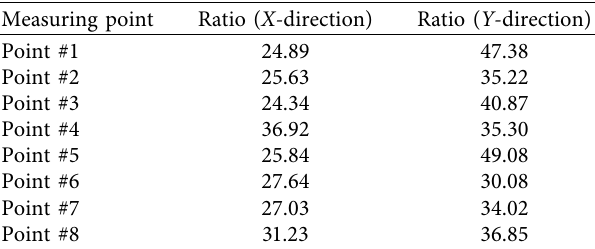
Figure 7: The location of the measuring points. Table 2: The vibration mission ratio at different measuring points in the X- and Y